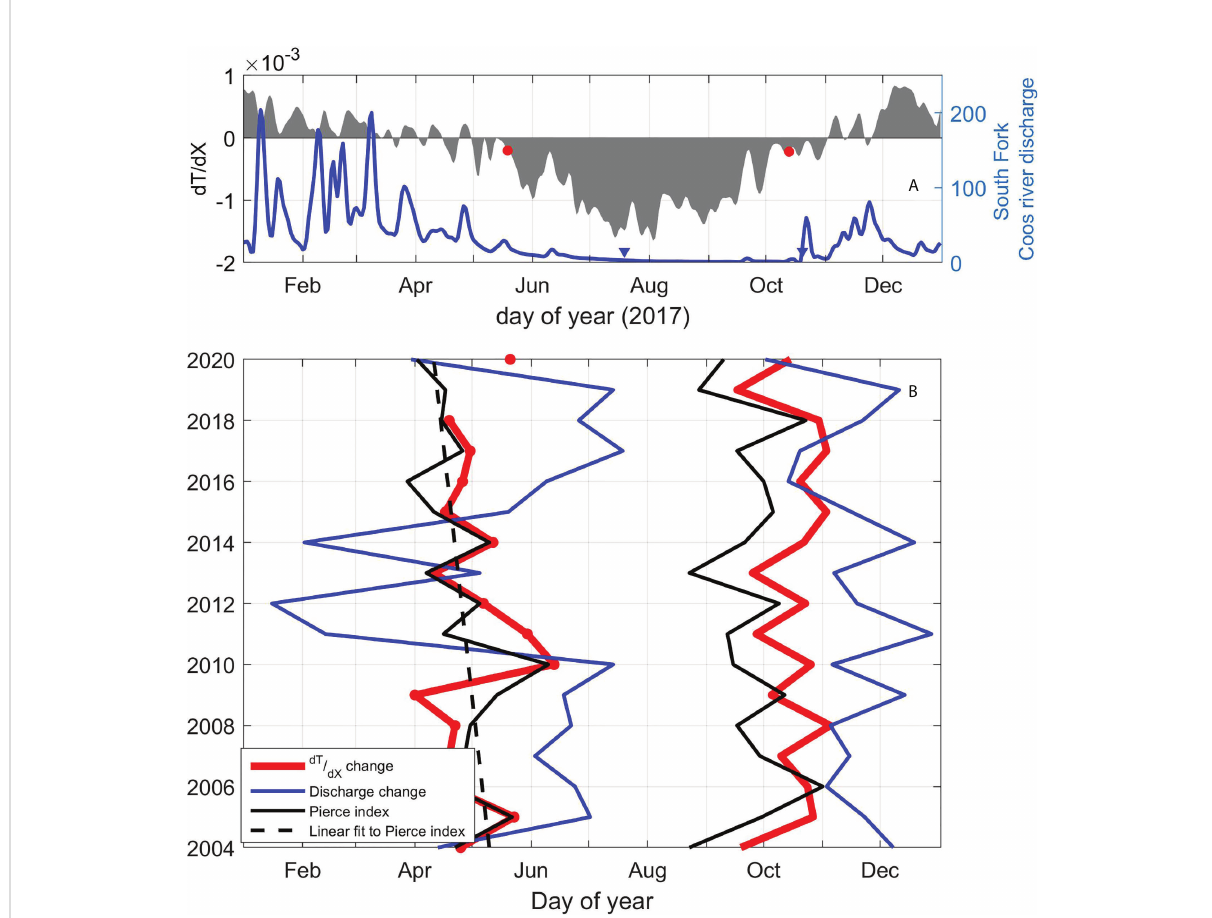
FIGURE 10 (A) Temperature gradient and discharge transition date determination example (2017) and zero-crossing of gradients before and after the dry season. (B) Annual variability of transition periods: in red spring and summer temperature gradient change (notice no available data for 2019); in blue South Fork of the Coos River discharge transition dates; in black Pierce index (2006) spring and fall transition dates for all years. Statistically signi fi cant linear fi t to Pierce index spring transition (2006) in black broken